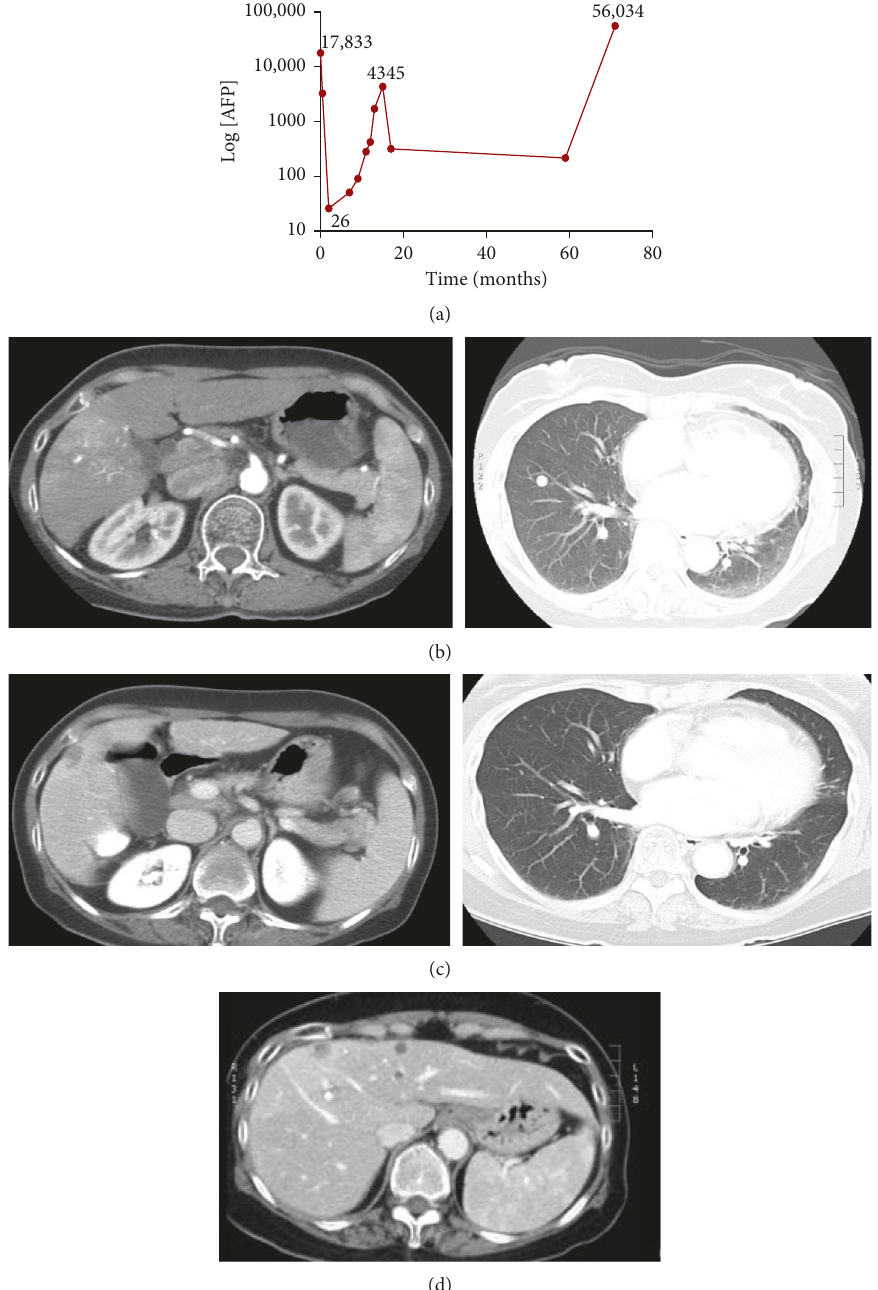
Figure 1: Spontaneous regression of HCC. (a) Serial changes in AFP levels (expressed as Log 10) over 18months of follow-up and the time points of CT-scans. (b) A 4 4cm liver lesion and bilateral lung lesions. (b) CT scan two months after diagnosis: the liver lesion has × diminished in size (2.5 1.5cm), and the lung lesions are barely visible. (c) CT scan at 17 months. The l liver lesion continues to be stable × (now measuring 1.2 1.1cm). (d) Recurrent liver ×